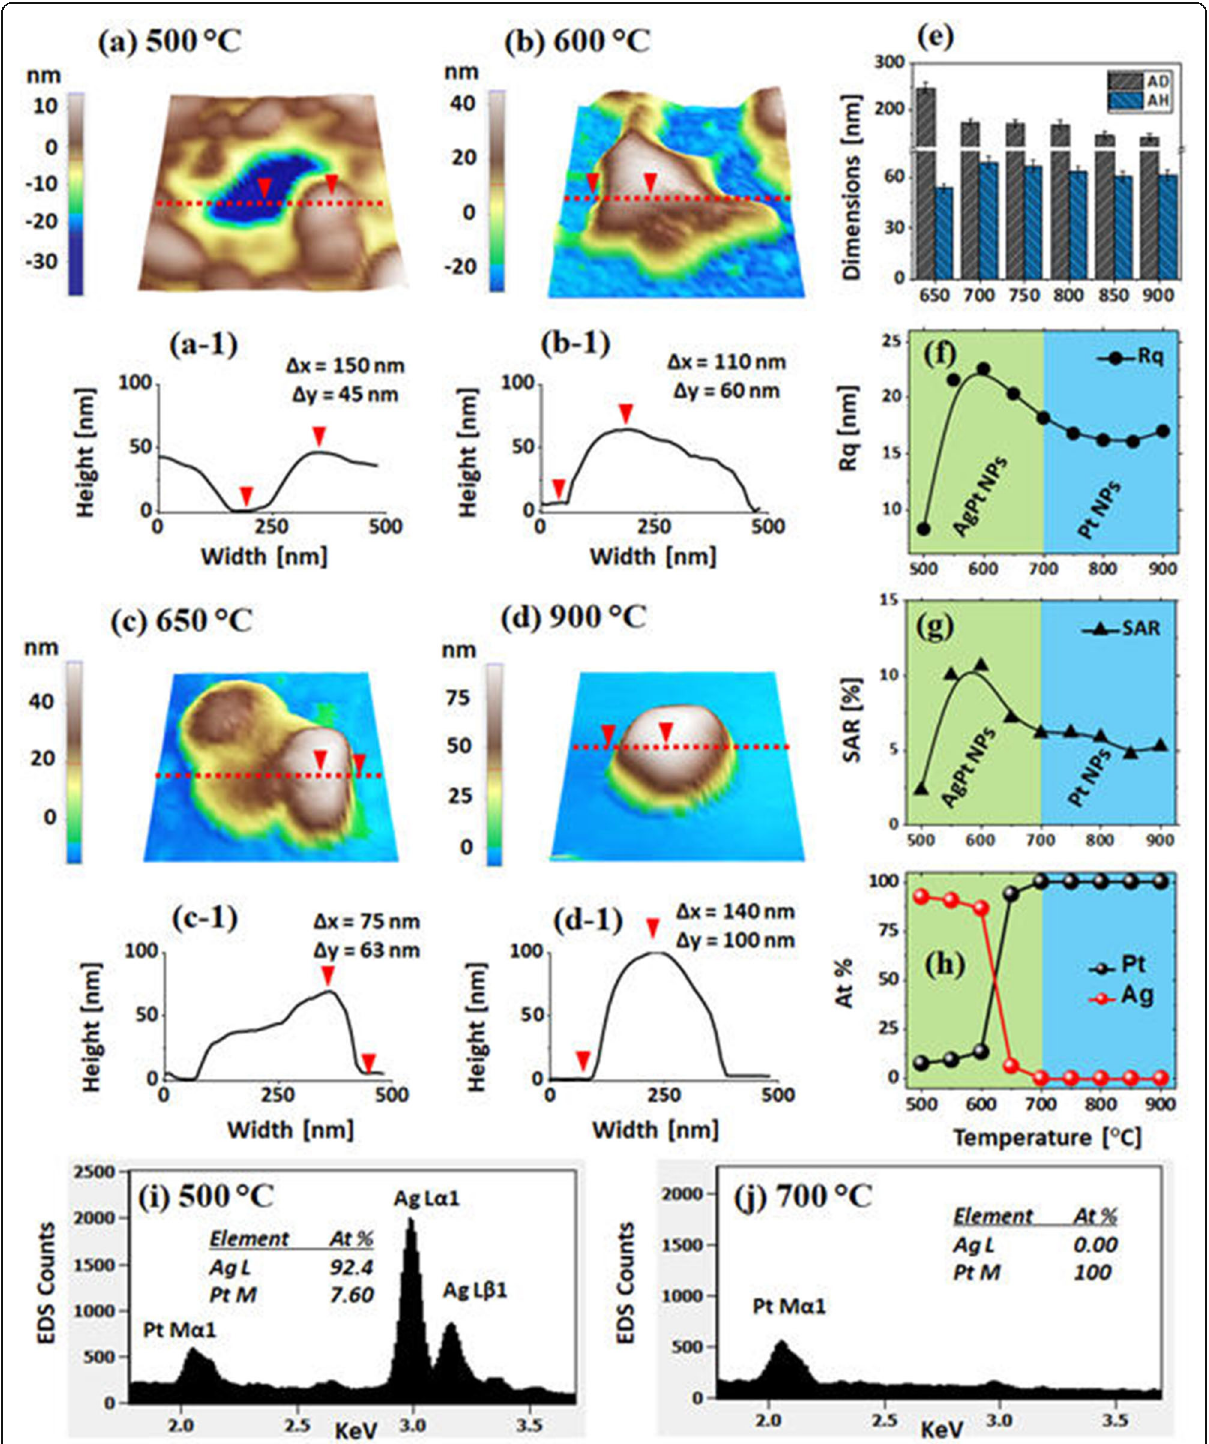
Fig. 5 Evolution of AgPt nanoclusters and Pt NPs by the dewetting of Ag 21nm /Pt 4.5nm bilayers between 500 °C and 900 °C for 120 s. a – d AFM side-views of 500 × 500 nm 2 . ( a-1 ) – ( d-1 ) Cross-sectional line profiles. e Summary plots of AD and AH of isolated NPs above 650 °C. f, g Summary plots of Rq and SAR. h Plot of at % of Ag and Pt at increased temperatures. i , j EDS spectra of the samples annealed at 500 and 700 °C. The elemental composition of Ag and Pt are enclosed in the EDS